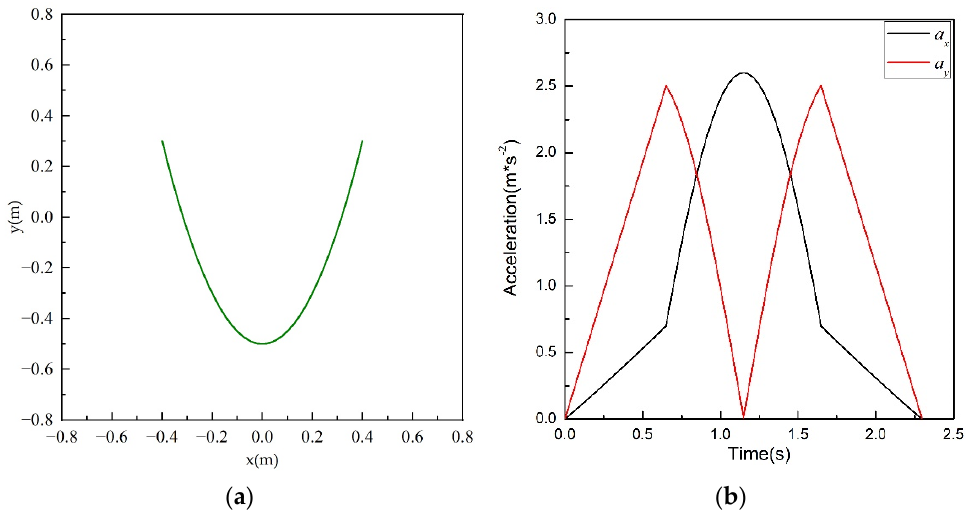
Figure 5. Parabolic motion trajectory and acceleration of moving platform. ( a ) Motion trajectory; ( b ) Acceleration curve.